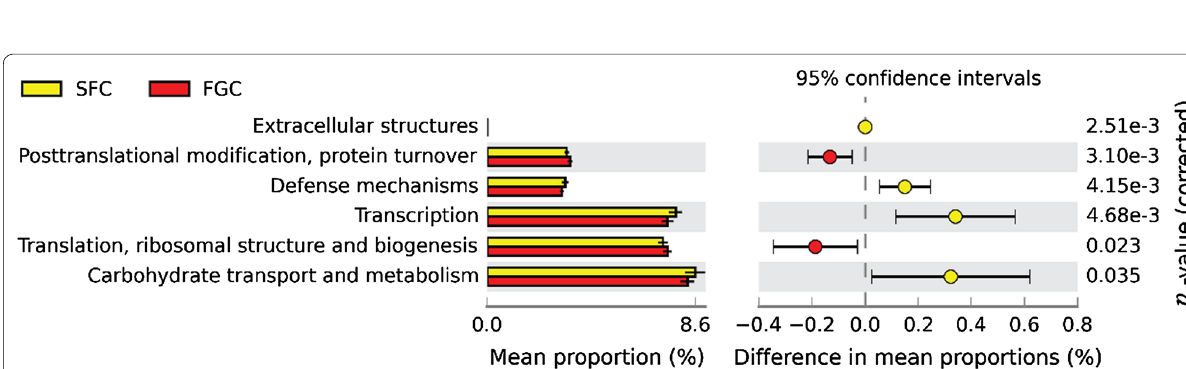
0.05, **means 0.001 < P 0.01 ≤ ≤